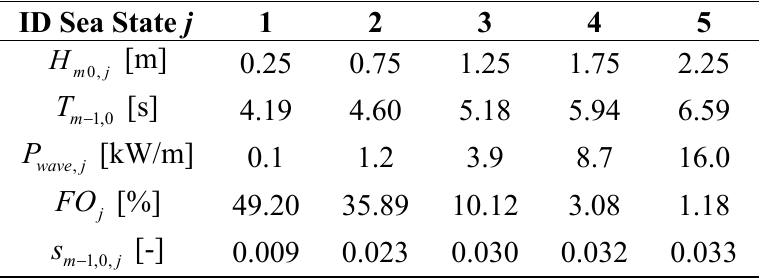
Table 4. Characteristic sea states for location on the Belgian Continental Shelf (Ostend), h = 6 m, source scatter diagram: Flemish Ministry of Transport and Public Works, Agency t for Maritime and Coastal Services—Coastal Division.